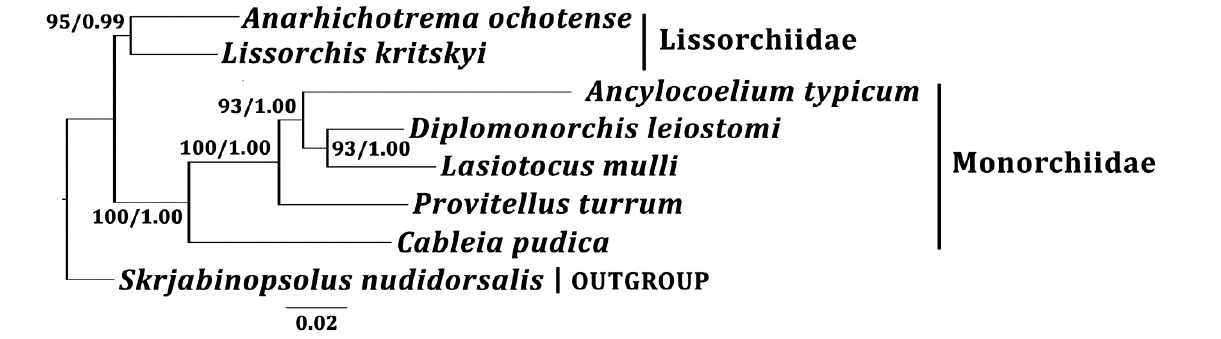
Figure 2. Phylogenetic relationships of Anarhichotrema ochotense based on concatenated dataset of 18S+28S rRNA gene sequences. The bootstrap ( ≥ 50) and posterior probability ( ≥ 0.90) values are given near the nodes for ML and BI analyses, respectively.